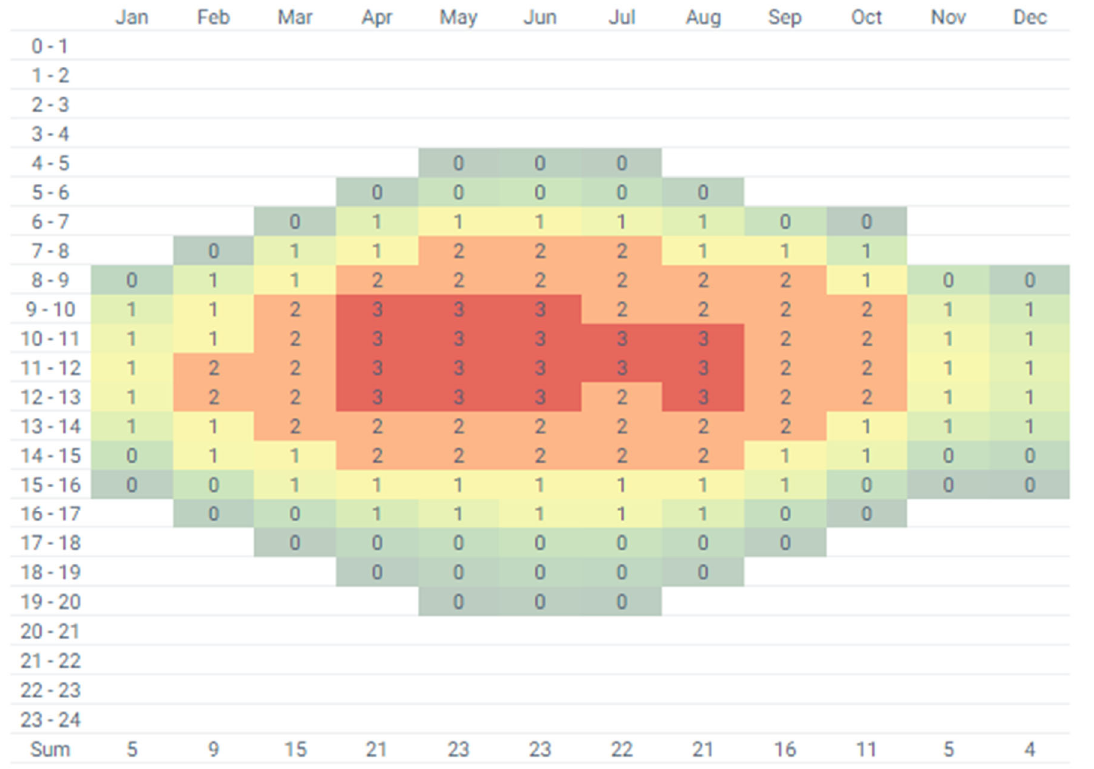
Figure 6. Diagram showing the average hourly electricity production profile for the designed photovoltaic system [50]. Table 5. Hourly profile of production of energy from the micro-installation on a percentage